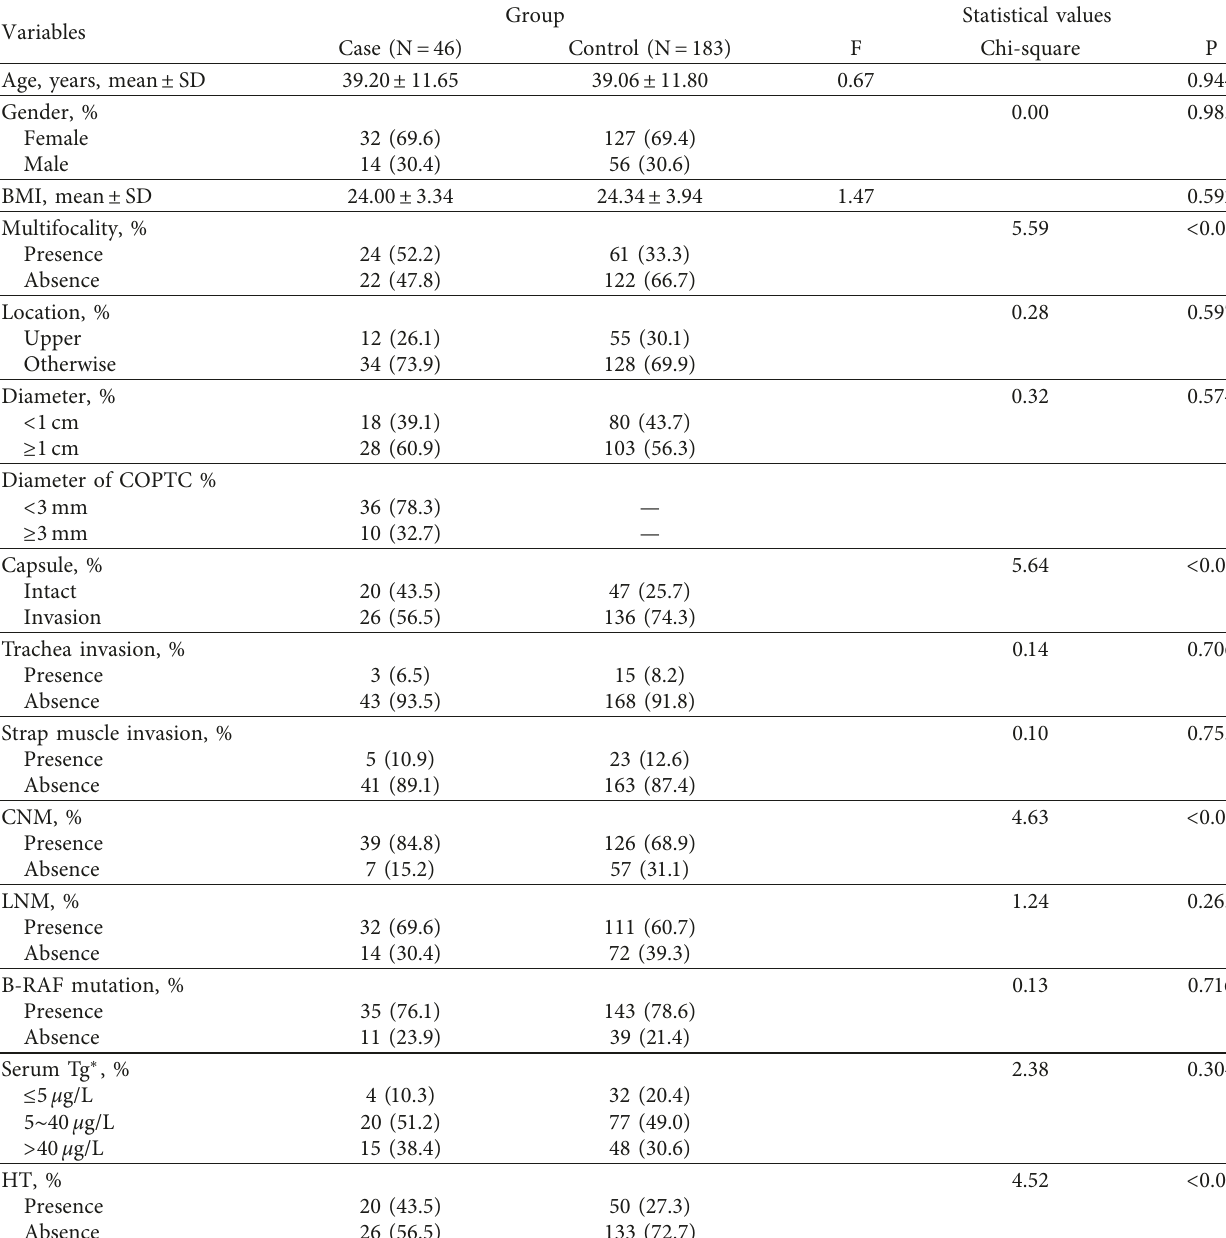
Table 1: Distribution of clinical and pathological characteristics in 229